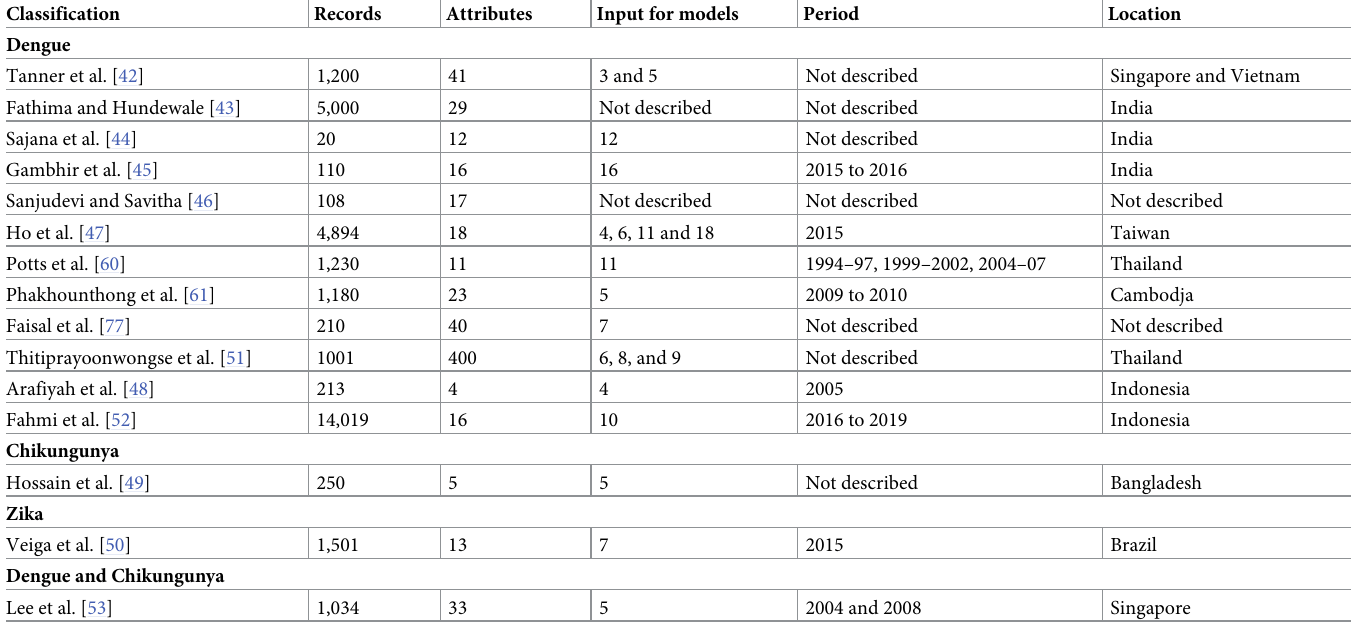
Table 2. Characteristics of the data sets used to evaluate Machine Learning and Deep Learning models for arboviral diseases